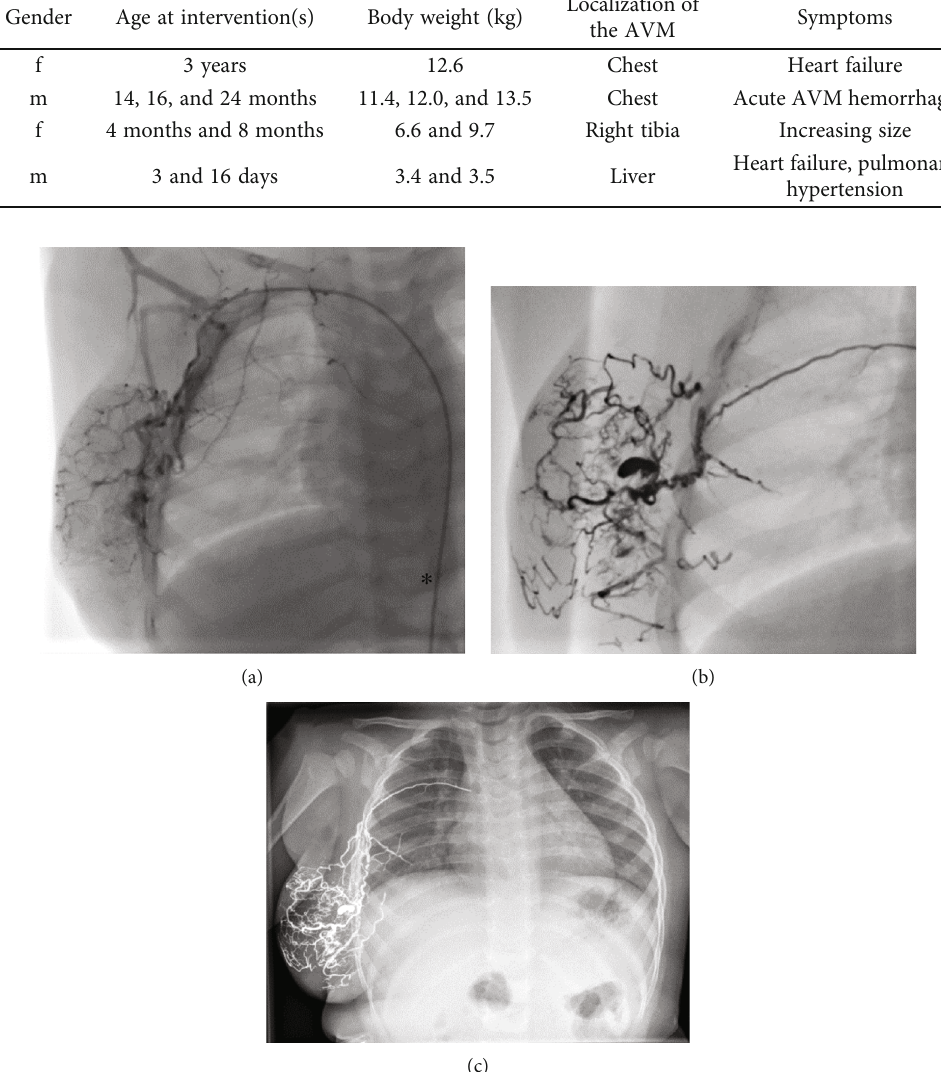
Figure 1: Imaging of the thoracic AVM in patient 2. (a) Angiographical imaging after injection of Solutrast 300® via a transarterial catheter (asterisk) into the feeding arteries deriving from the right subclavian artery. (b) Angiographical imaging after injection of radiopaque Onyx®. (c) Radiographic imaging (X-ray) of the thorax after the last